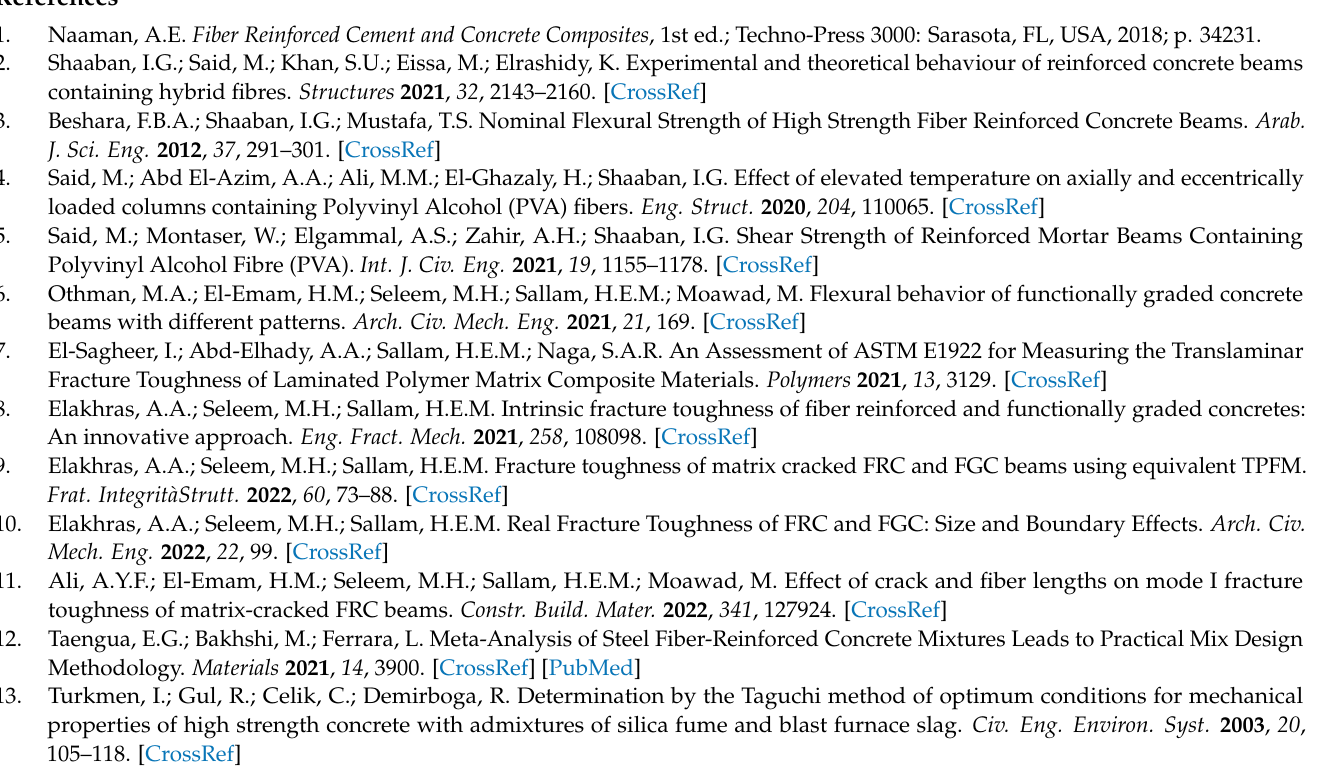
weighted normalized decision matrix, and single response for the TOPSIS method. Table S2: Calculated (S/N) ratios and normalized decision matrix for FTOPSIS. Table S3: Fuzzy TOPSIS application— weighted normalized decision matrix and defuzzification results. Table S4: Fuzzy TOPSIS